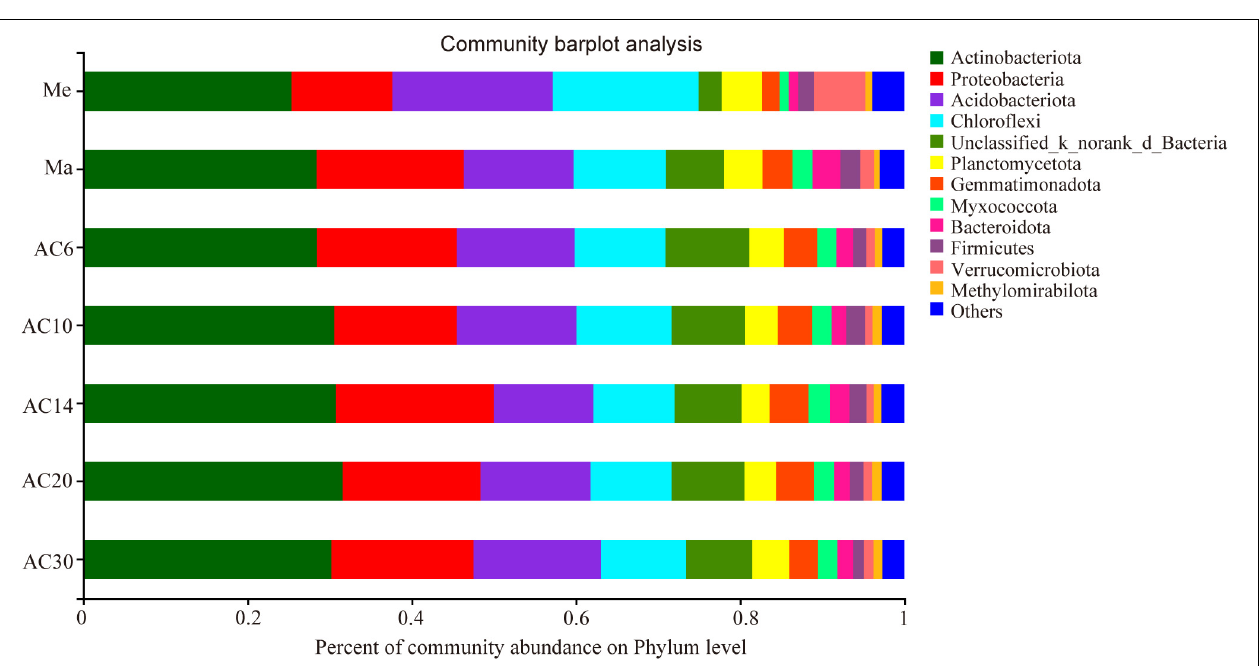
FIGURE 2 | Effect of crop type and continuous cropping years on the bacterial